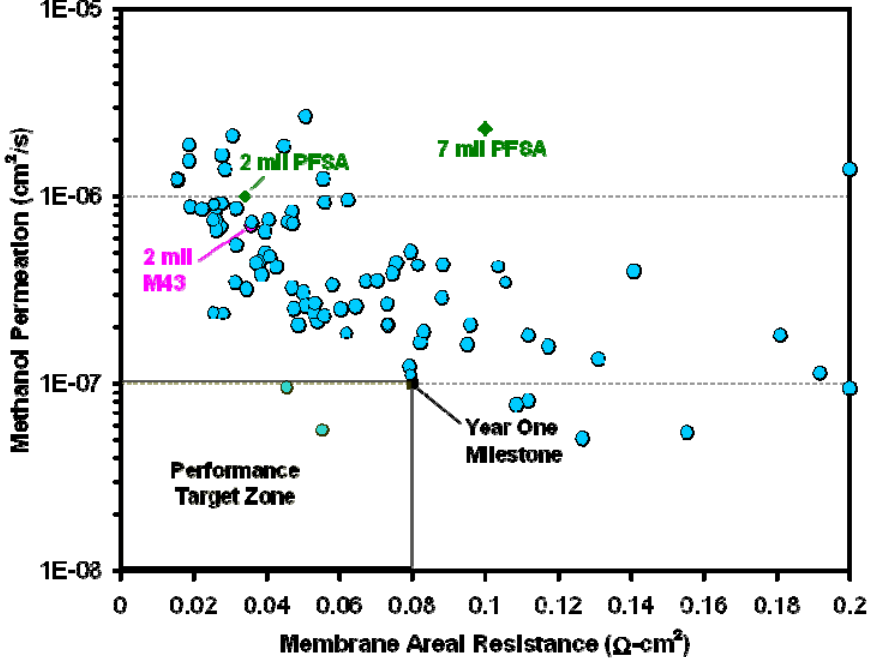
Figure 14. Results of DMFC membrane screening for areal resistance and methanol permeability